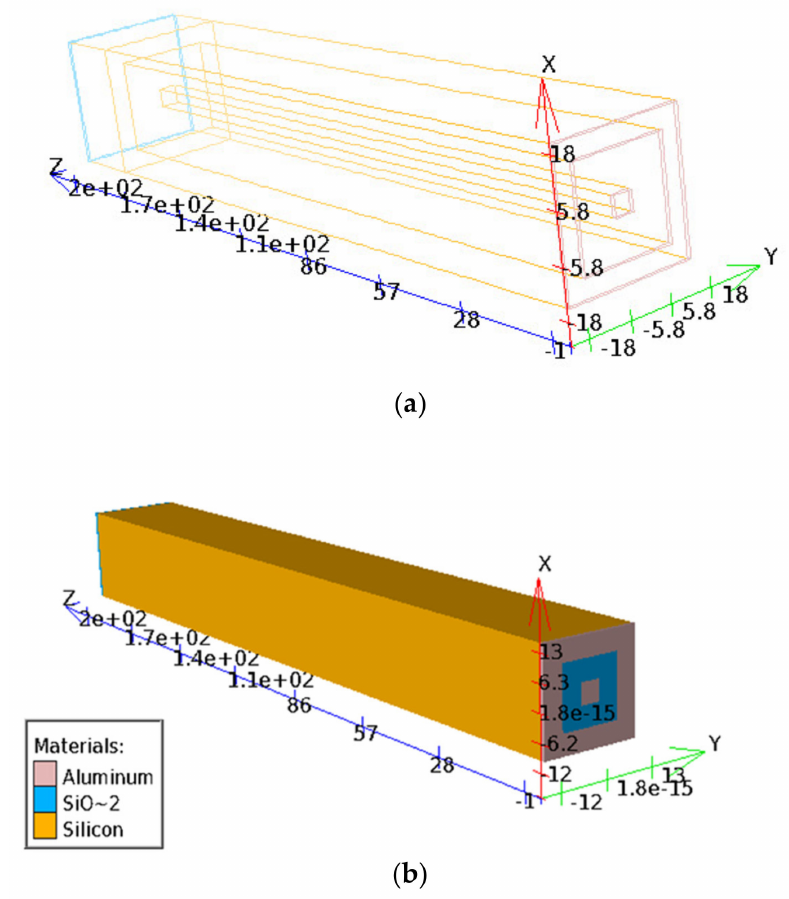
Figure 2. 3D simulation of the square ultra-fast 3D-trench electrode detector structure. The axis